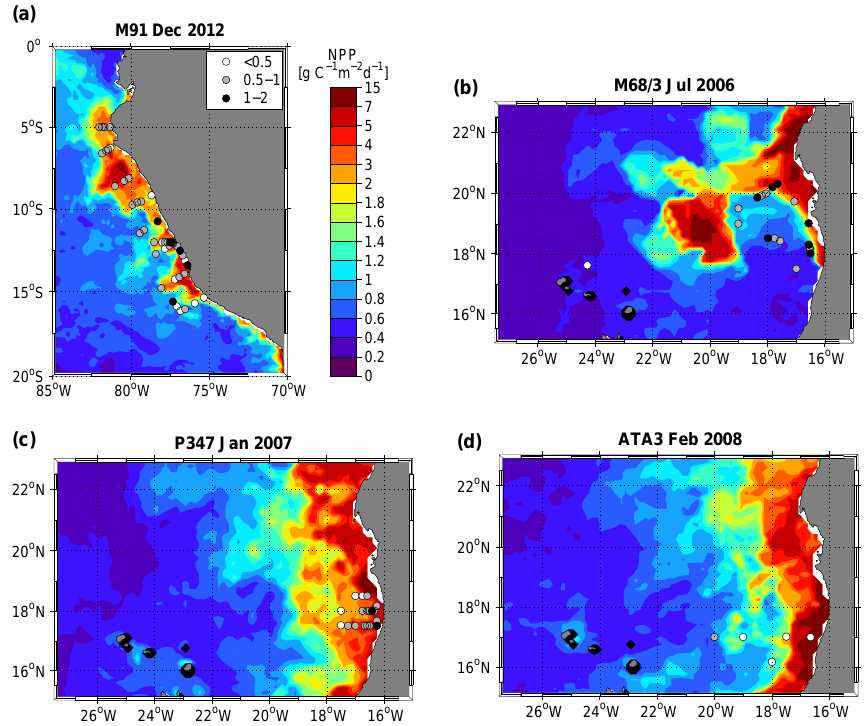
Figure 8. Mean net primary production over the time period of the respective cruise for M91 (a) , M68/3 (b) , P347 (c) , and ATA3 (d) . The vertical phosphate transport (advective plus diffusive part) into the mixed layer is converted to carbon units by the Redfield ratio and indicated by the grey dots. Note that the error of these fluxes is 100%. For details see text. Table 3. Mean advective, diffusive, and total PO 4 fluxes into the mixed layer converted to carbon units [gCm − 2 d − 1 ] via the Redfield ratio. M91 M68/3 P347 ATA3 coastal offshore coastal offshore coastal offshore coastal offshore adv. 1 . 0 ± 0 . 3 0 . 4 ± 0 . 1 1 . 1 ± 0 . 4 0 . 7 ± 0 . 3 0 . 8 ± 0 . 3 0 . 2 ± 0 . 1 – 0 . 4 ± 0 . 3 diff. 0 . 3 ± 0 . 1 0 . 5 ± 0 . 1 0 . 9 ± 0 . 2 0 . 9 ± 0 . 2 0 . 8 ± 0 . 4 0 . 2 ± 0 . 1 0 . 9 ± 0 . 3 0 . 08 ± 0 . 03 total 1 . 3 ± 0 . 3 0 . 9 ± 0 . 1 2 . 1 ± 0 . 5 1 . 6 ± 0 . 4 1 . 6 ± 0 . 5 0 . 4 ± 0 . 1 – 0 . 5 ± 0 .